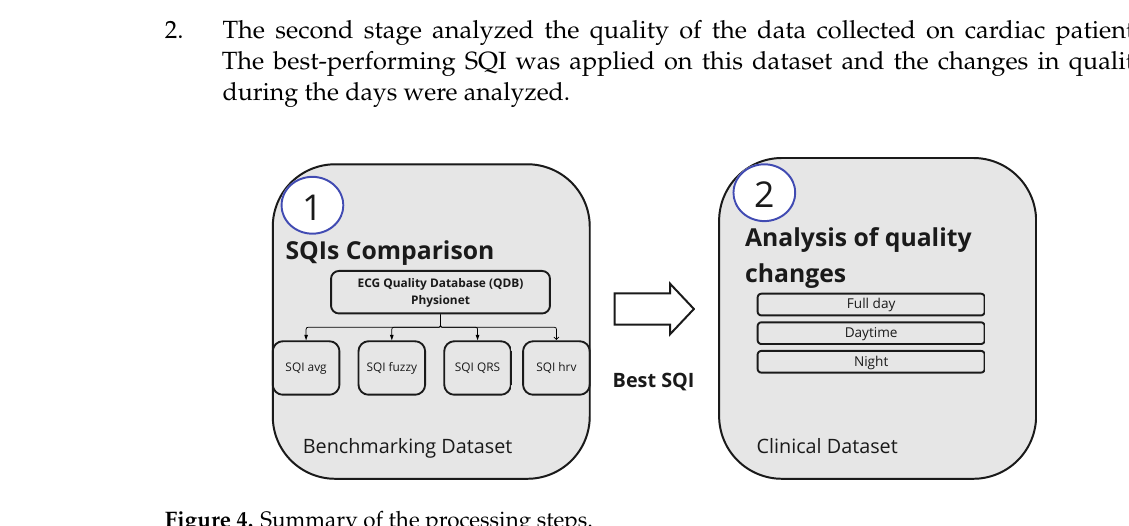
Figure 4. Summary of the processing